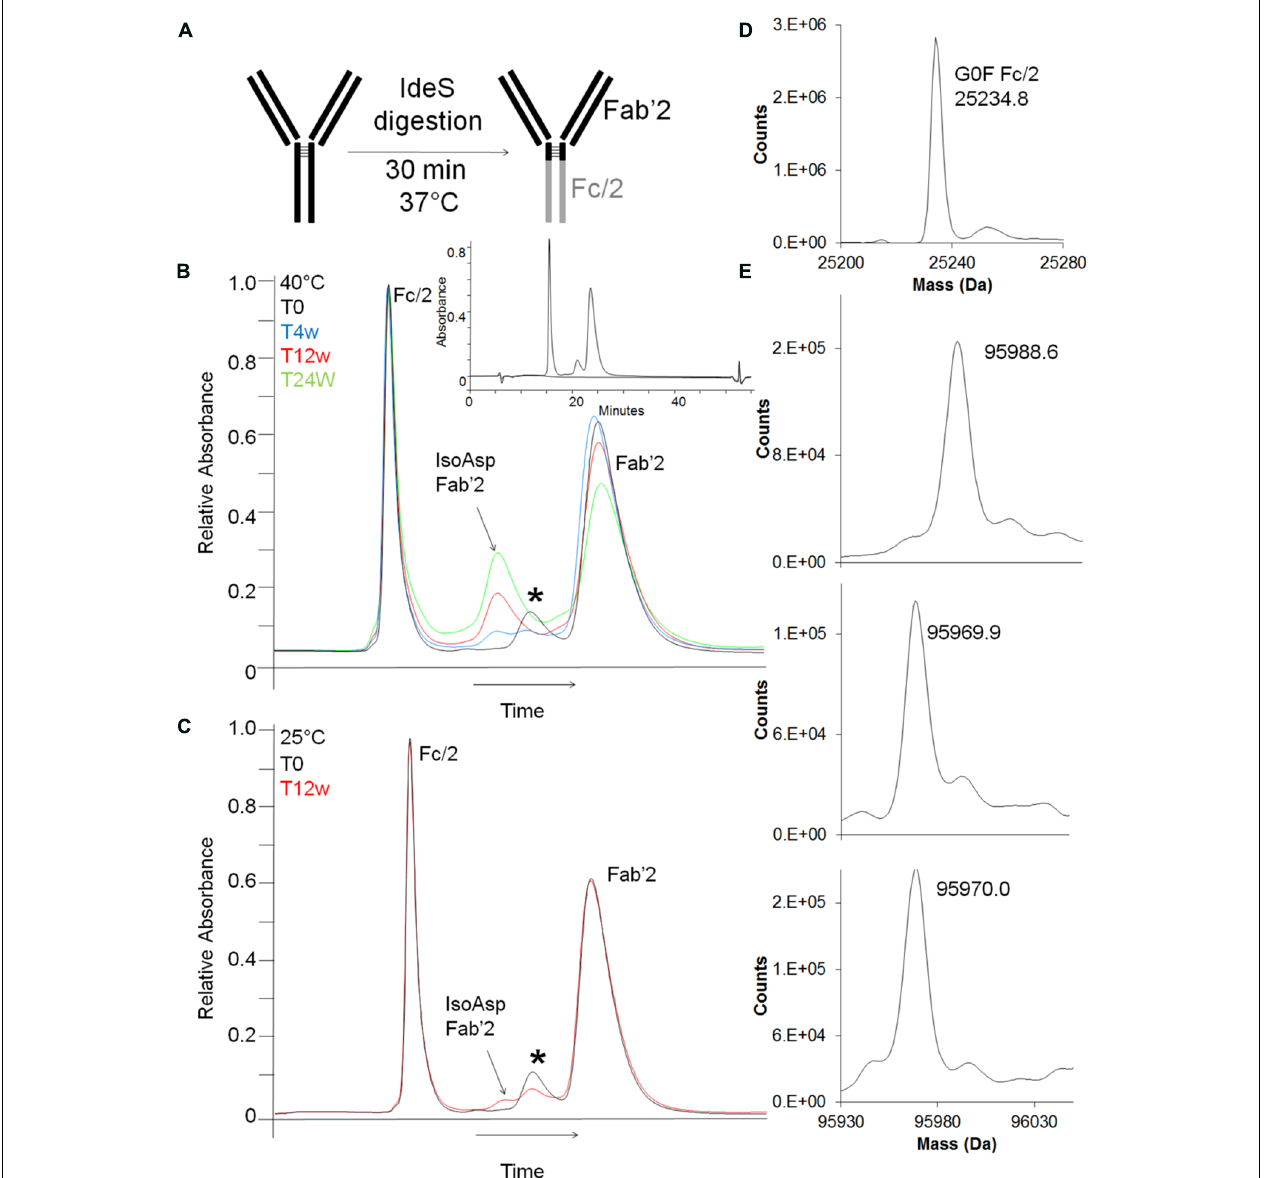
x-axis has been normalized to the main peak to account for normal chromatographic drift. Peak identifications shown in (B,C) were assigned by intact mass analysis (D,E) of peaks fractionated from HIC. (D) Intact mass of the Fc/2 fractionated from the HIC. (E) Top panel is Fab’2 with one HC not cyclized to pyroglutamic acid and corresponds to the peak labeled with * in (B,C) . The middle panel corresponds to the Fab’2 with isoAsp in one HC and the bottom panel is